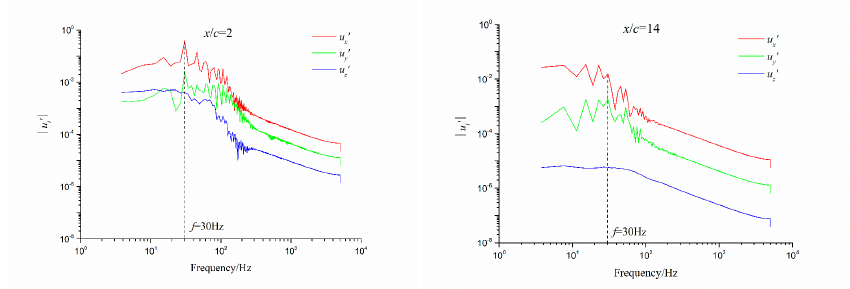
( a ) Spectral plots of velocity fluctuation at f = 20 Hz, left: |(cid:1873) (cid:3051)(cid:4593) |, right: |(cid:1873) (cid:3052)(cid:4593) | .